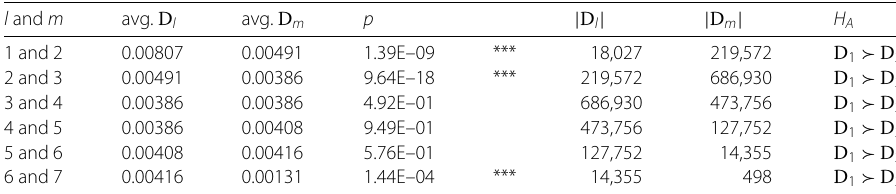
Table 8 One-sided independent two-sample Welch’s t -test on the difference in trade synchronization score for pairwise consecutive social distance. Here, D k is the set of the synchronization scores between investors at the distance k l and m avg. D l avg. D m